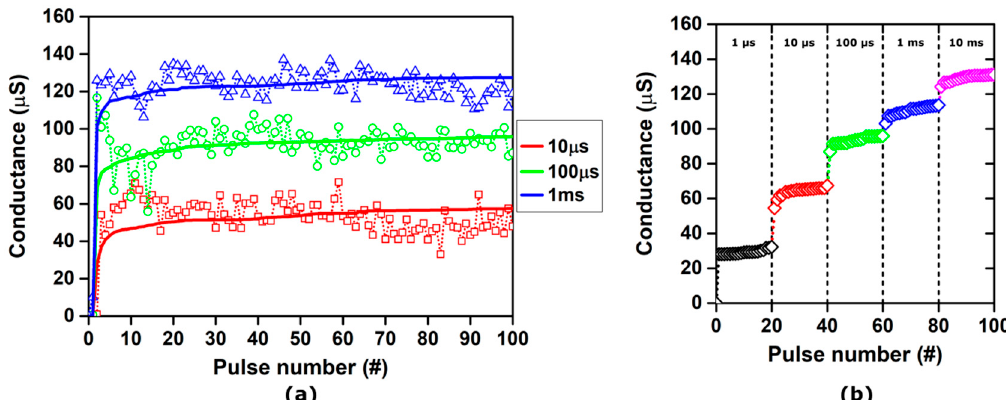
Figure 8. ( a ) Experimental (symbols) and simulated (lines) conductance evolution of TiN/6 nm HfO x /TiO y /TiN RRAM stacks under the application of set pulse trains with a 0.9 V amplitude and different widths: (red) 10 µS; (green) 100 µS; (blue) 1 ms. Initial forming was performed with a 100 µA compliance current. ( b ) Simulated conductance modulation obtained using set pulse trains with an increasing width: (black) 1 µS; (red) 10 µS; (green) 100 µS; (blue) 1 ms; (magenta) 10 ms.